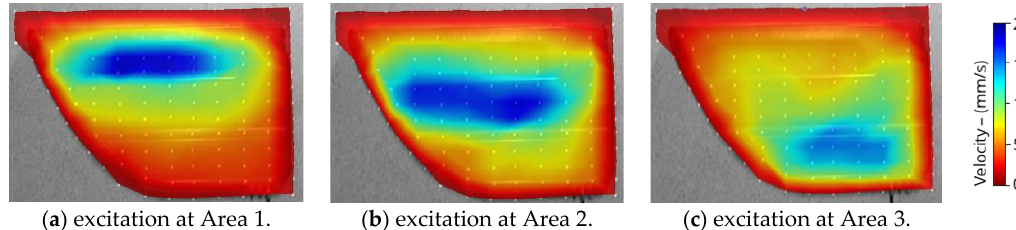
( c ) excitation at Area 3. Figure 7. Measured averaged out-of-plane velocities (RMS values) in the frequency range between 818 Hz and 10.3 kHz for the excitation using the integrated piezoceramic transducers in the following areas: ( a ) Area 1, ( b ) Area 2, and ( c ) Area 3.